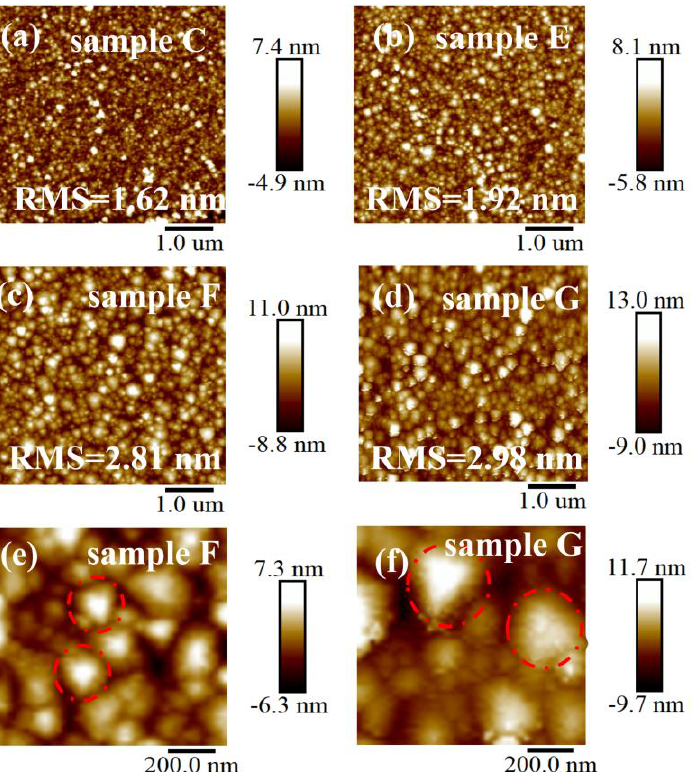
Figure 6. AFM images of the α -Ga 2 O 3 films grown at different carrier gas flow rates: ( a ) 3000 sccm, ( b ) 4000 sccm, ( c ) 5000 sccm, and ( d ) 5000sccm, N 2 as carrier gas. High-magnification AFM images: ( e ) sample F, ( f ) sample G.